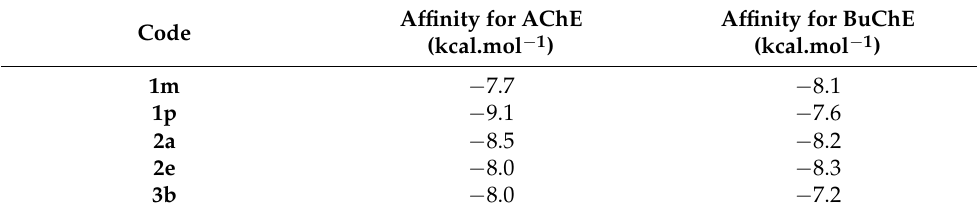
Table 4. Binding energies of selected ligands to AChE and BuChE.